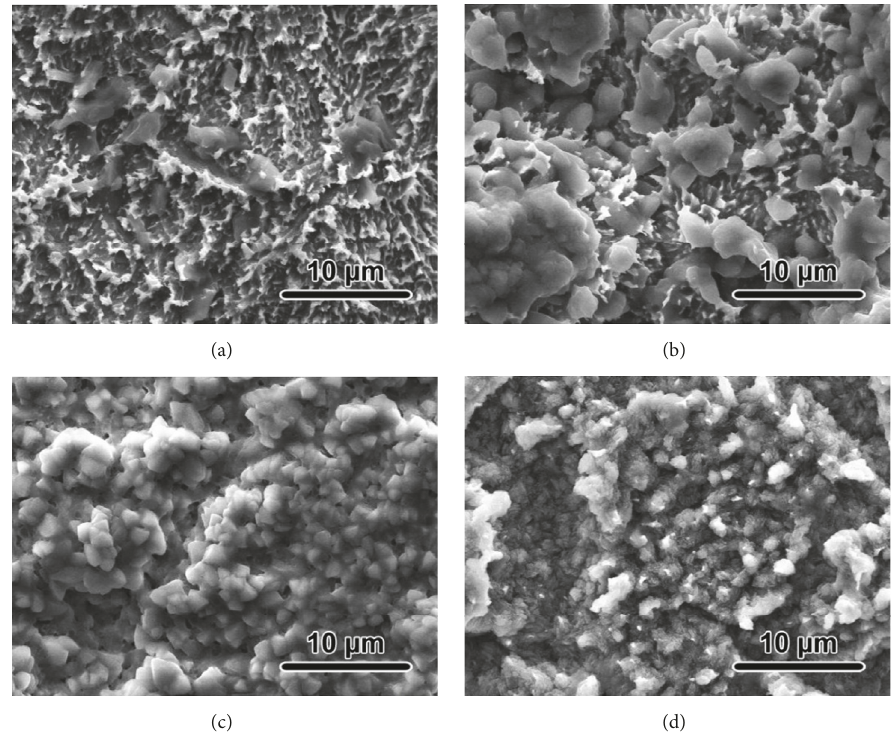
Figure 5: Surface morphology changes with increasing spray-drying repetition number: (a) 20 times; (b) 60 times; (c) 100 times; (d) 140